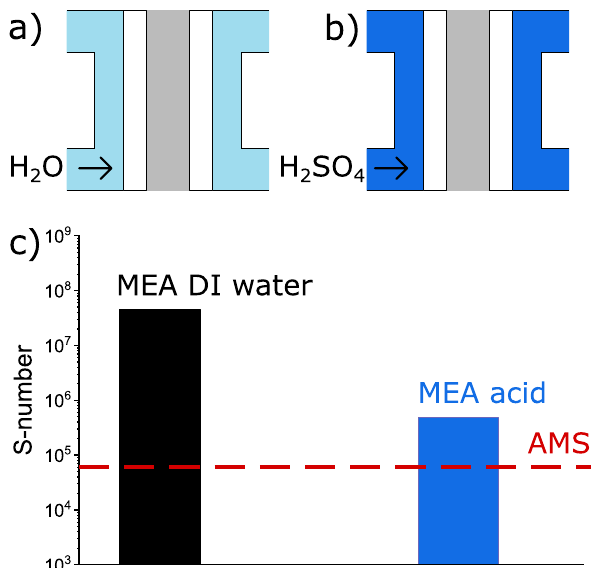
Fig. 4 Comparison of stability in different systems. a Working principle of an MEA operated with DI water. b Working principle of an MEA operated with 0.1 M H 2 SO 4 . c S-numbers of MEAs operated with DI water and 0.1 M H 2 SO 4 after 2 h of measurement. The red, dashed line in c indicates the S- number of the AMS system. Source data are provided in the source data fi